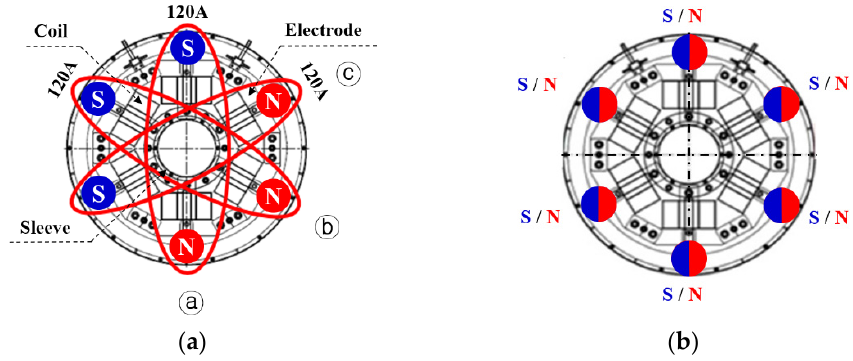
Figure 1. Schematic diagram of the six-pole electromagnet: ( a ) DC, ( b )